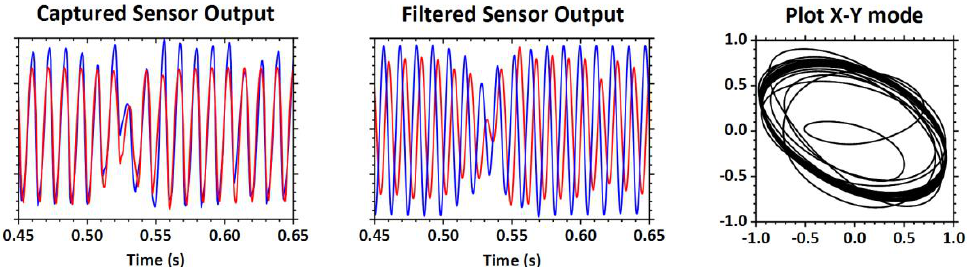
Figure 15. Example of processing of FEM simulated signals from active and passive sensors.